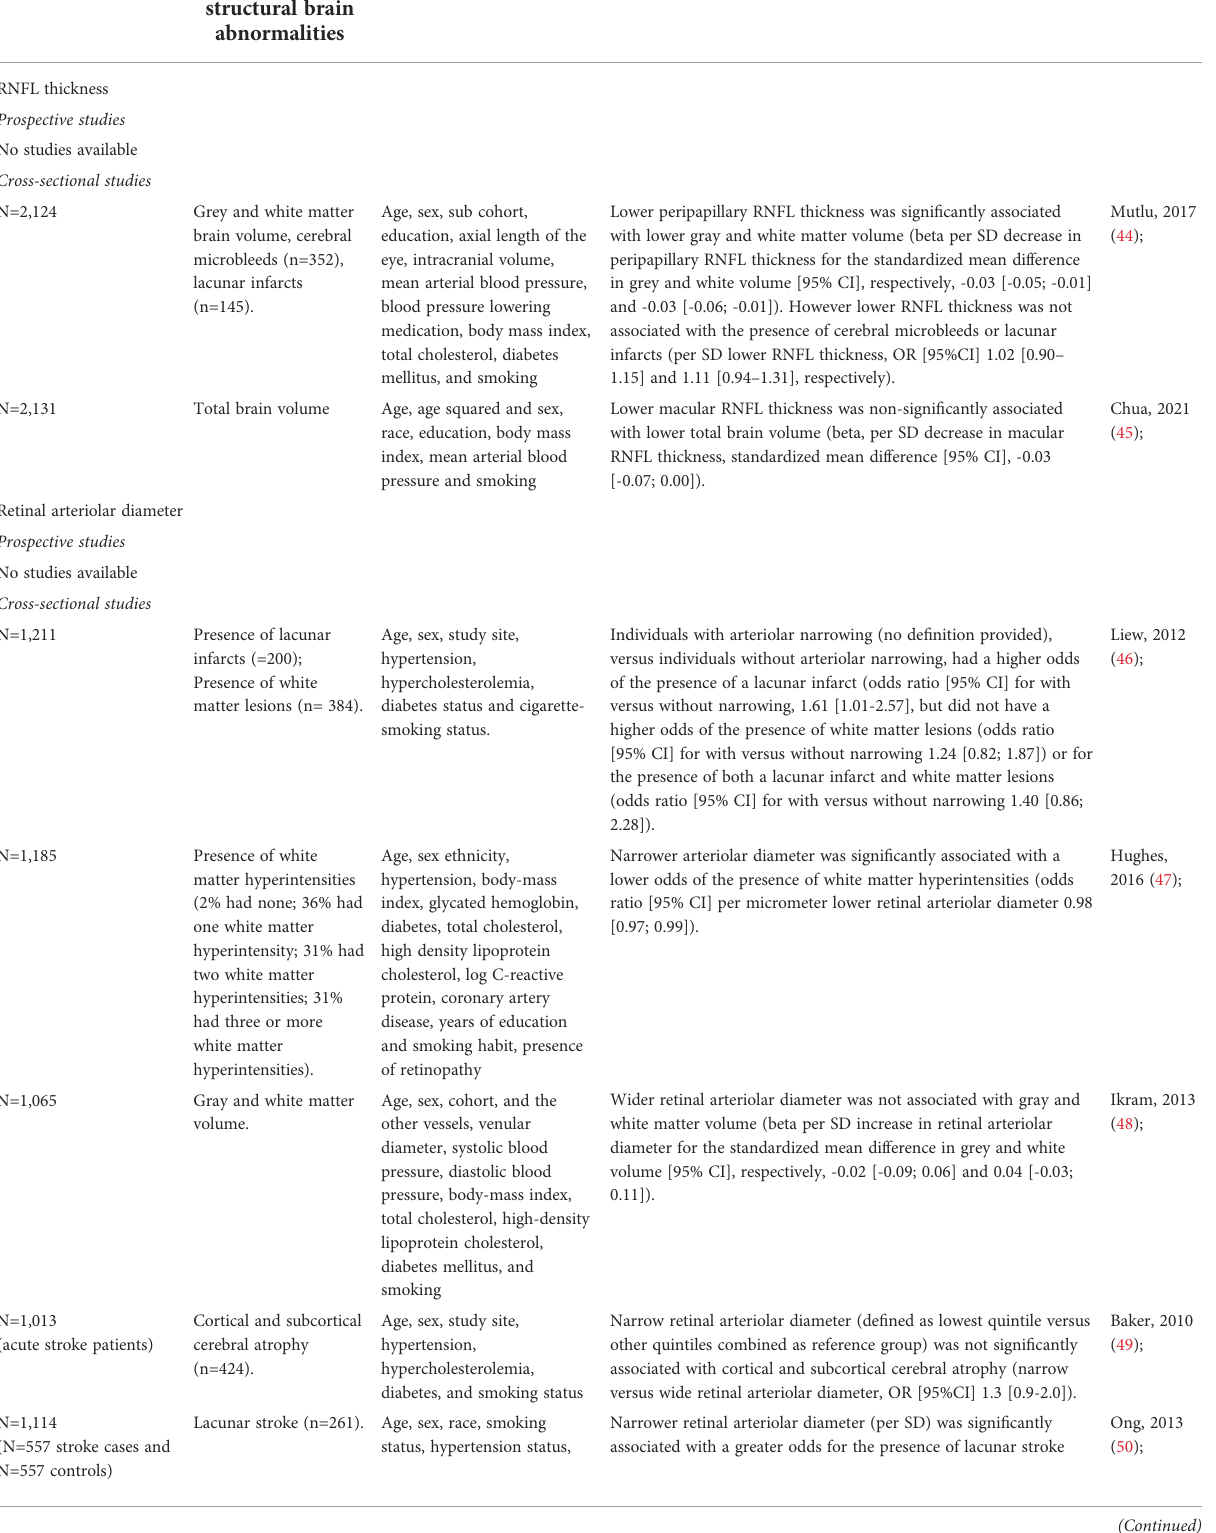
TABLE 2 Associations of neuronal and microvascular structures and function of the neurovascular coupling unit, as quanti fi ed by retinal imaging, with cerebral MRI features of structural brain abnormalities.